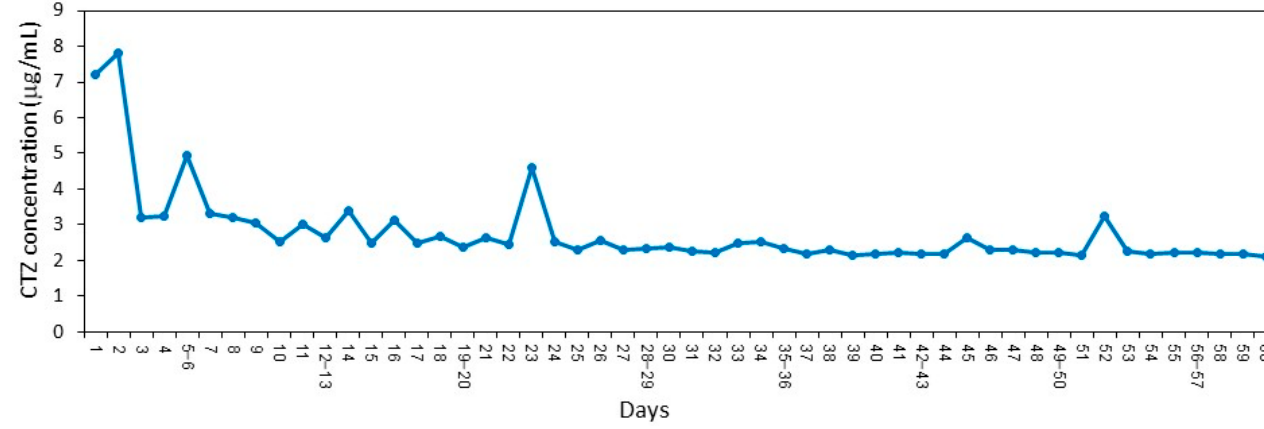
Figure 4. HPLC analysis of the daily release of CTZ from VP coated with SRV-CTZ. VP coated with SRV-CTZ was daily incubated in 1 mL PBS for 24 h at 37 °C and the CTZ concentration of the soluble fraction was determined by HPLC according to a standard curve using known concentrations of CTZ in PBS. N = 1.